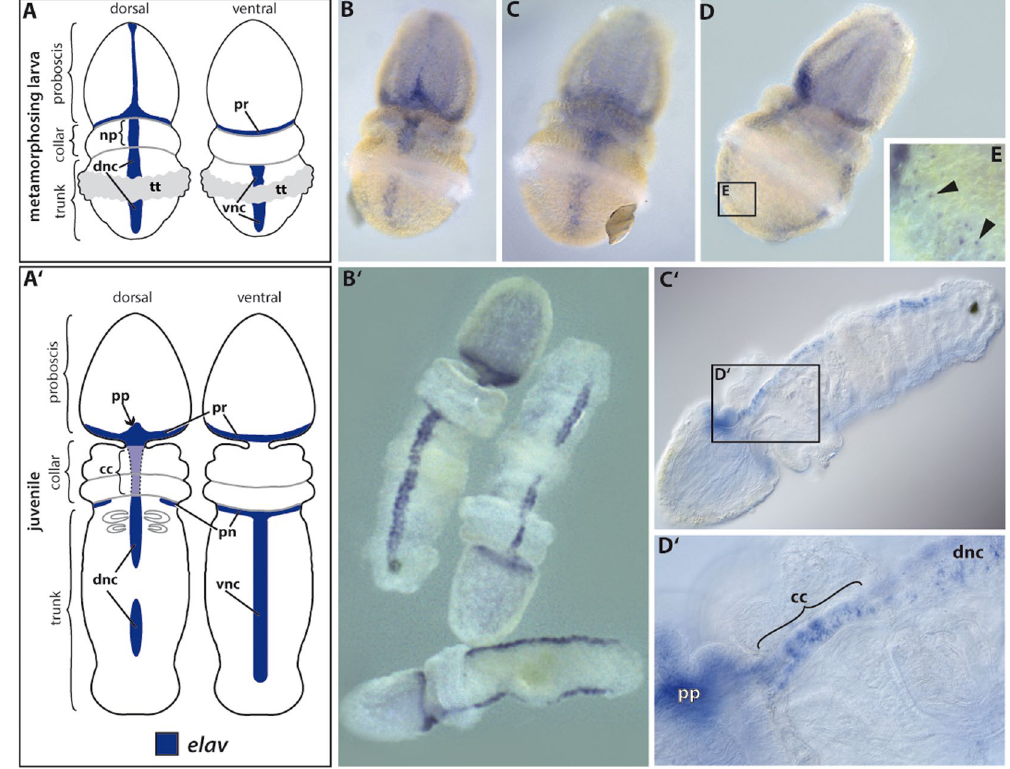
Figure 1. Establishment of the adult nervous system. Gene expression of BmiElav in the metamorphosing larva and juvenile of B. misakiensis . ( A – E ) Metamorphosing larva. (A’–D’) Juvenile. ( A ) Schematic illustration of BmiElav expression. BmiElav is expressed in the proboscis nerve ring, the developing dorsal nerve cord including the neural plate in the collar ( B,D ) and in the ventral nerve cord ( C,D ). Note that the expression is interrupted at the level of the telotroch. E Detail of the lateral trunk showing scattered neurons (arrowheads). (A’) Schematic illustration of BmiElav expression in juveniles. Note that the collar cord is neurulated. B’ Surface view from ventral, dorsal and lateral right (from top to bottom) showing strong expression in the proboscis nerve ring, proboscis plexus, and in the dorsal as well as ventral nerve cord. BmiElav expression is discontinuous in the middle of the dorsal nerve cord in the trunk region. (C’) Micrograph of cleared juvenile. (D’) Detail showing Elav + cells in the subepidermal collar cord. cc = collar cord, dnc = dorsal nerve cord, np = neural plate, pn = peribranchial nerve ring, pr = proboscis nerve ring, pp = proboscis plexus, tt = telotroch, vnc = ventral nerve cord. ( B ) dorsal view. ( C ) ventral view. ( D ) view from lateral